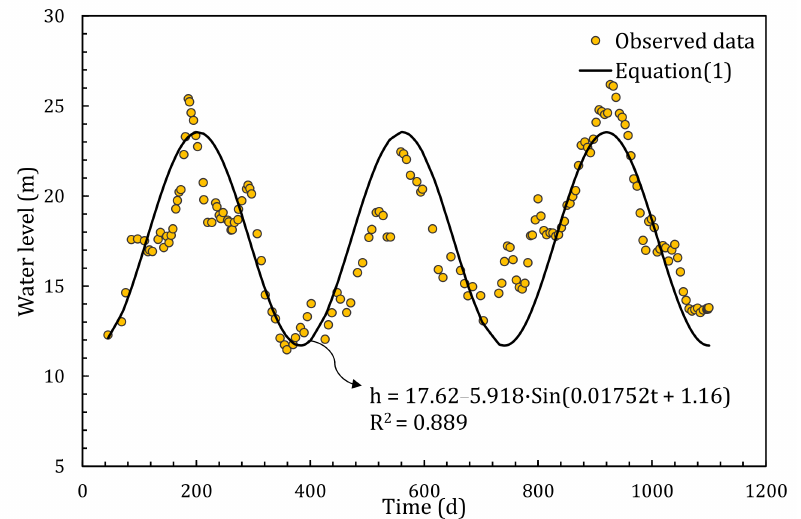
Figure 5. Comparison of calculation results and observed data of the water level of the Yangtze